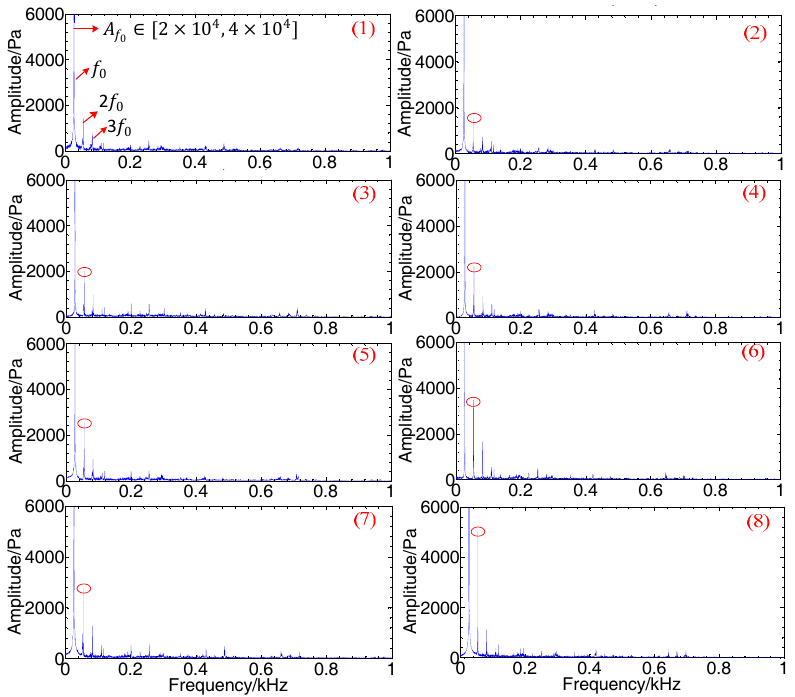
Figure 14. Spectrum analysis of domain signal collected from Block 1 in Strip 1.